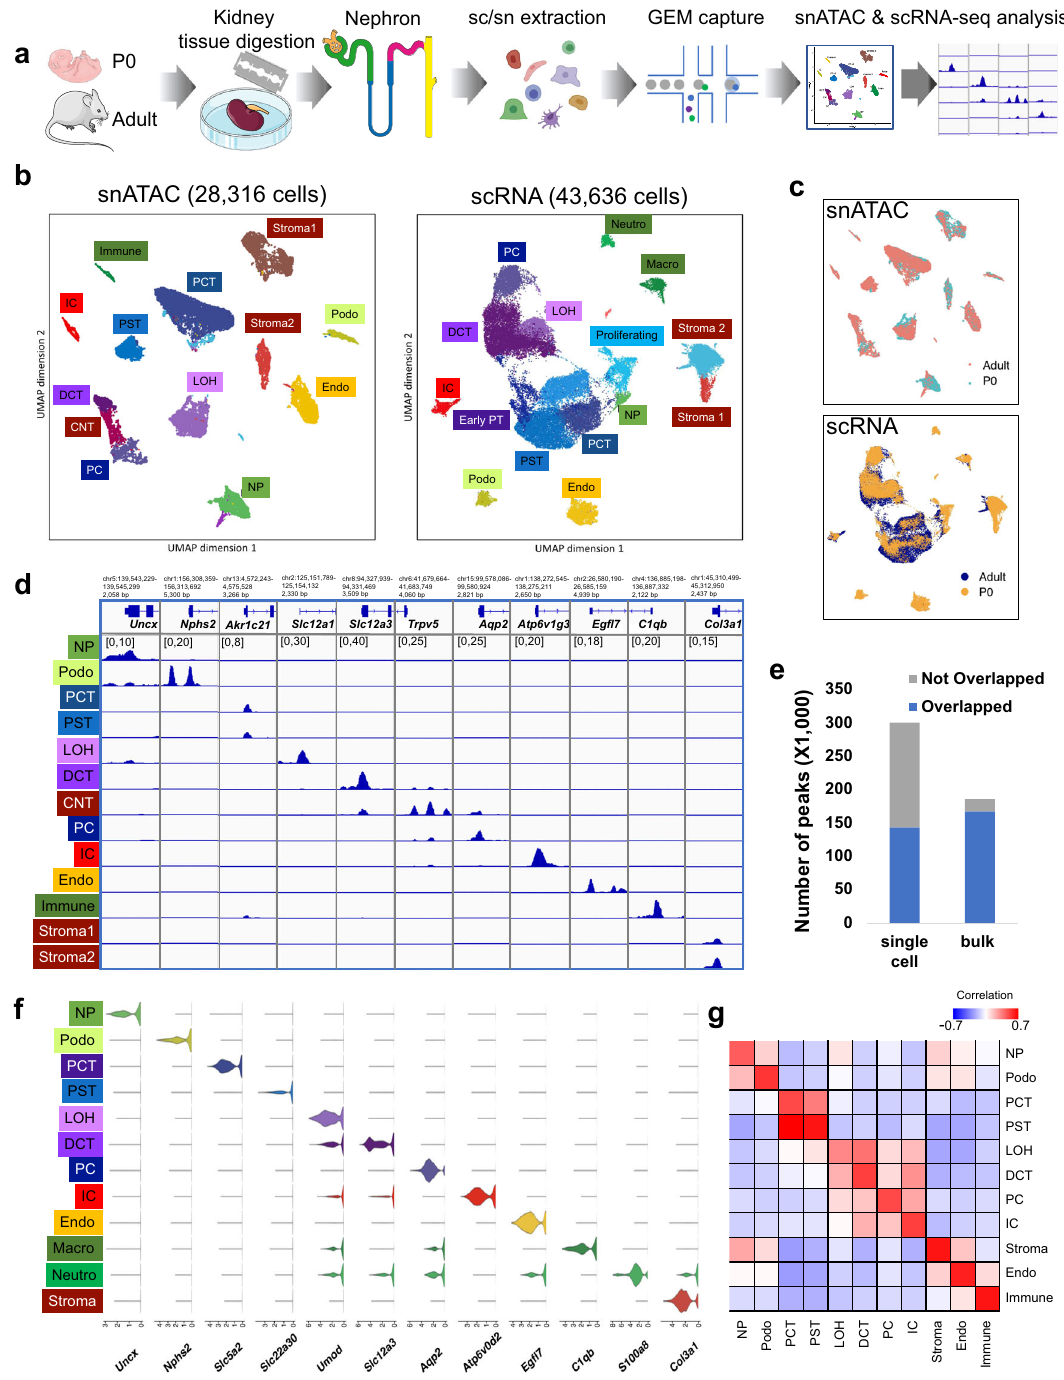
Fig. 1 snATAC-seq and scRNA-seq identi fi ed major cell types in developing and adult mouse kidney. a Schematics of the study design. Kidneys from P0 and adult mice were processed for snATAC-seq and scRNA-seq followed by data processing and analysis including cell type identi fi cation and peak calling; artwork own production and from https://smart.servier.com, license https://creativecommons.org/licenses/by-sa/3.0/). b UMAP embeddings of snATAC-seq data and scRNA-seq data. Using marker genes, cells were annotated into nephron progenitors (NP), collecting duct intercalated cells (IC), collecting duct principal cells (PC), proximal convoluted and straight tubule (PCT and PST), loop of Henle (LOH), distal convoluted tubules (DCT), stromal cells (Stroma), podocytes (Podo), endothelial cells (Endo), and immune cells (Immune). In scRNA-seq data, the same cell types were identi fi ed, with an additional proliferative population and immune cells were clustered into neutrophils and macrophages. c UMAP embeddings of snATAC-seq and scRNA- seq data colored by P0 and adult batches. d Genome browser view of read density in each snATAC-seq cluster at cell type marker gene transcription start sites. Additional marker gene examples are shown in Supplementary Fig. 3a. e Comparison of peaks identi fi ed from snATAC-seq data and bulk ATAC-seq data. Peaks that are identi fi ed in both datasets are colored blue, and peaks that are dataset-speci fi c are gray. f Violin plots showing cell type-speci fi c gene expression in scRNA-seq data. g Heatmap showing Pearson ’ s correlation coef fi cients between snATAC-seq gene activity scores and gene expression values in P0 data. Each row represents a cell type in scRNA-seq data and each column represents a cell type in snATAC-seq data. The correlation of the adult dataset is shown in Supplementary Fig.